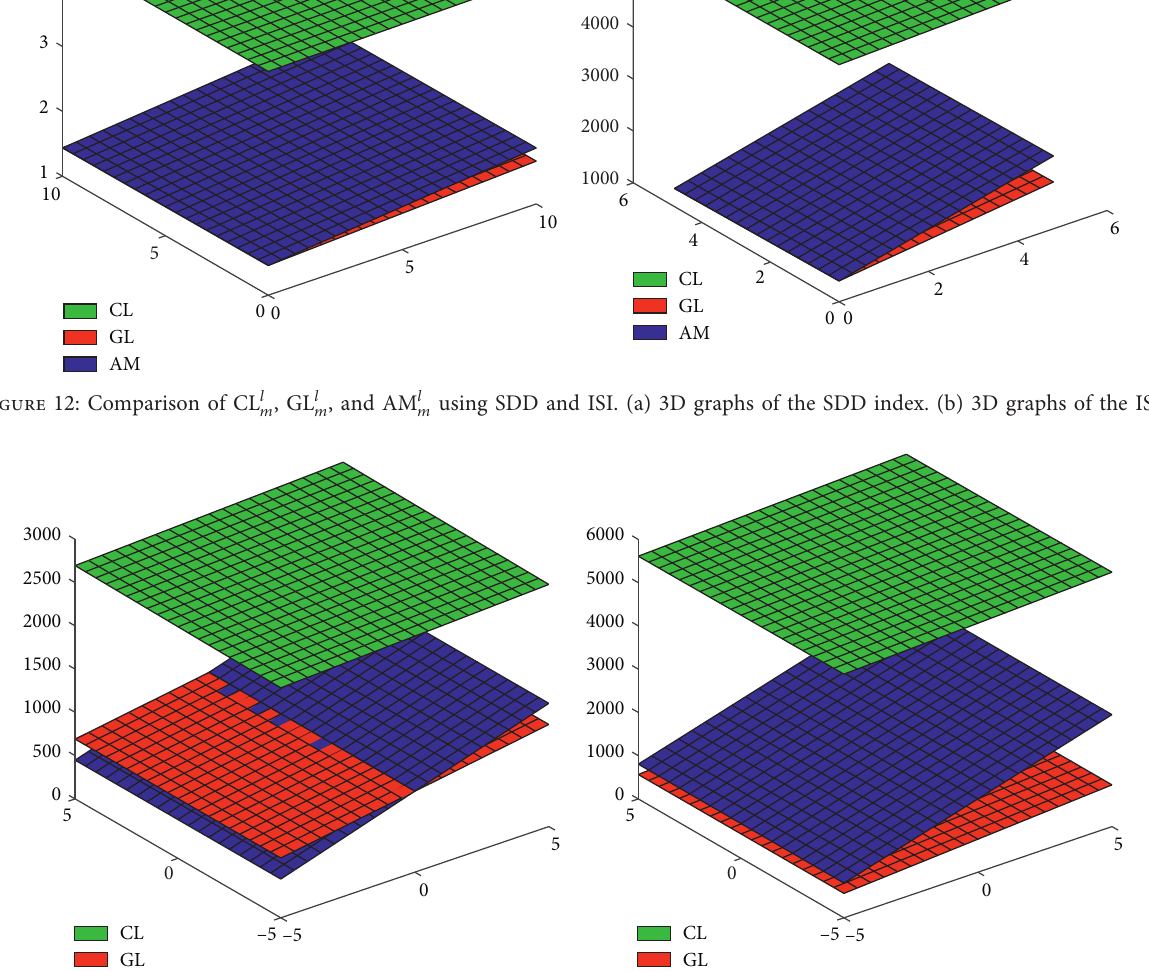
l l m , GL m , and AM m using ABC 4 and GA 5 . (a) 3D graphs of the ABC 4 index. (b) 3D graphs of the GA 5